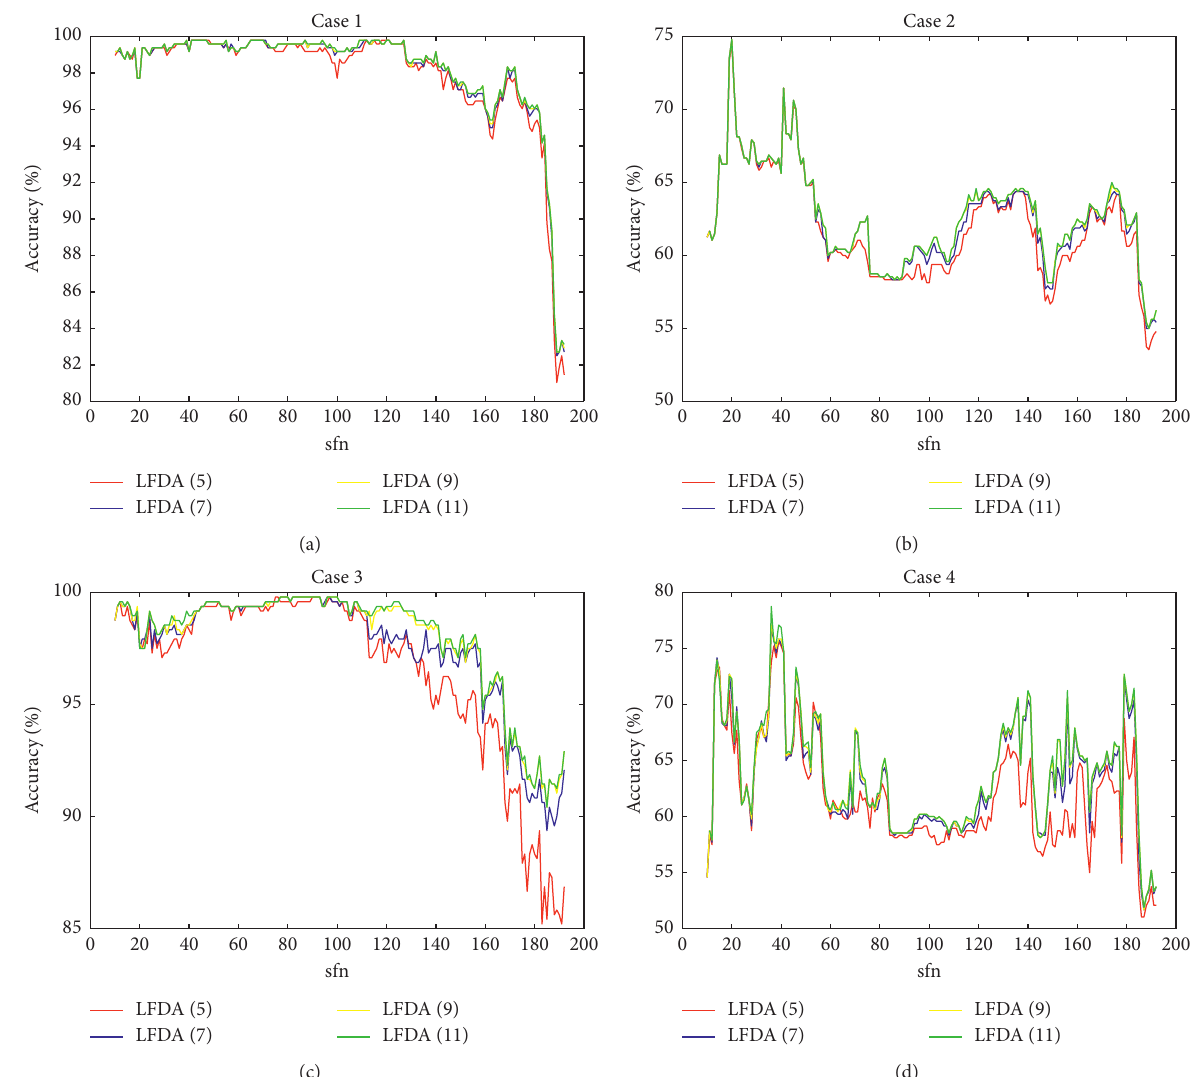
Figure 13: The curve representation of diagnosis results obtained by OFS-TSFRS-LFDA-SVM using WPTwith different dimension sizes for LFDA. The LFDA (5) represents that the number of dimension size is